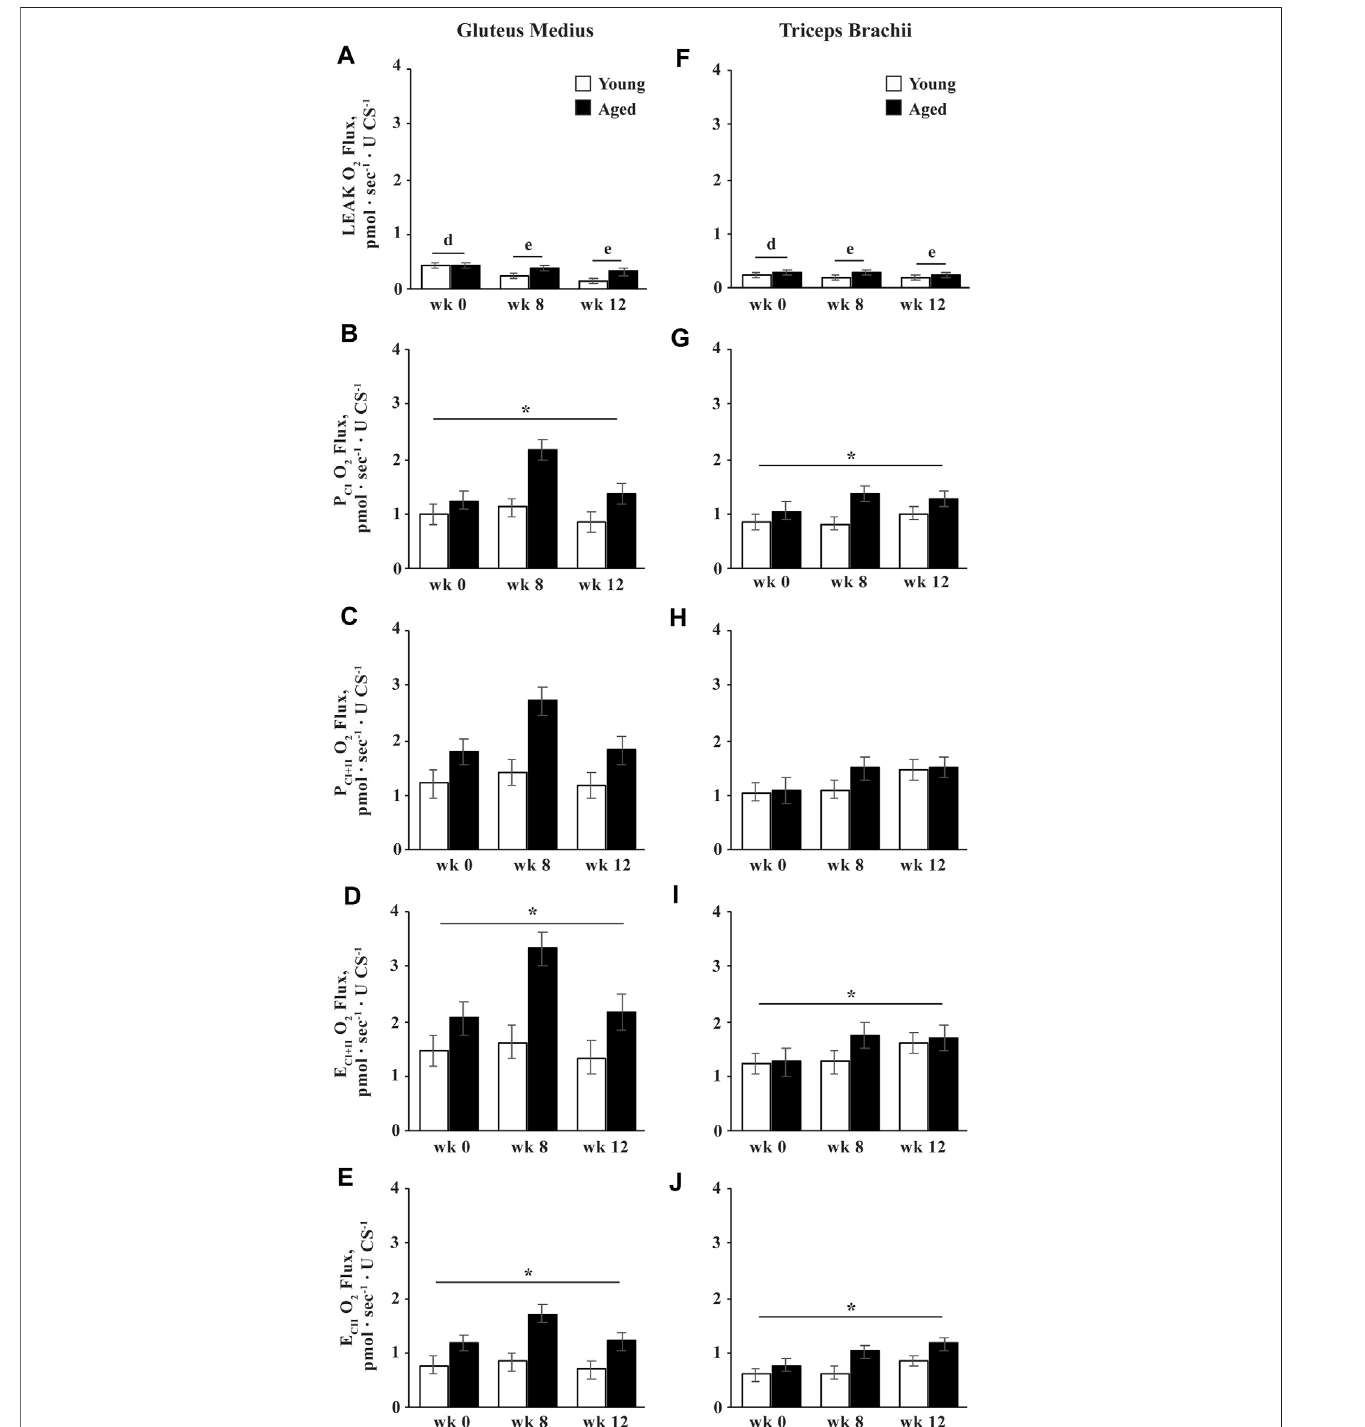
FIGURE 6 | Intrinsic (normalized to CS activity) mitochondrial respiration of permeabilized fi bers from the gluteus medius and triceps brachii analyzed via high- resolution respirometry. LEAK respiration (LEAK; A , F ), complex I-supported oxidative phosphorylation capacity (P CI ; B , G ), complex I and II-supported P (P CI+II ; C , H ), maximalnoncoupledelectrontransfersystemcapacity (E CI+II ; D , I ),andcomplexII-supportedE(E CII ; E , J )weremeasuredbefore(wk0),andafter8(wk8)and12(wk12) weeks of submaximal exercise training in aged (22 ± 4.5 yr; n (cid:1) 10) and young (9.7 ± 0.7 mo; n (cid:1) 8) horses. Overall effect of age ( p (cid:1) 0.15; p (cid:1) 0.05; p (cid:1) 0.05; p (cid:1) 0.04; p (cid:1) 0.04), training ( p (cid:1) 0.0005; p (cid:1) 0.056; p (cid:1) 0.12; p (cid:1) 0.10; p (cid:1) 0.12), muscle group ( p (cid:1) 0.2; p (cid:1) 0.5; p (cid:1) 0.5; p (cid:1) 0.3; p (cid:1) 0.3), age × training ( p (cid:1) 0.06; p (cid:1) 0.11; p (cid:1) 0.2; p (cid:1) 0.14; p (cid:1) 0.2),age × musclegroup( p (cid:1) 0.7; p (cid:1) 0.9; p (cid:1) 0.99; p (cid:1) 0.9; p (cid:1) 0.8),training × musclegroup ( p (cid:1) 0.3; p (cid:1) 0.6; p (cid:1) 0.5; p (cid:1) 0.5; p (cid:1) 0.4),and age × training × musclegroup ( p (cid:1) 0.8; p (cid:1) 0.9; p (cid:1) 0.9; p (cid:1) 0.9; p (cid:1) 0.97) for LEAK, P CI ,P CI+II , E CI+II , and E CII , respectively.*Aged differs from young( p < 0.05). d,e Time points with different letters differ ( p < 0.05).